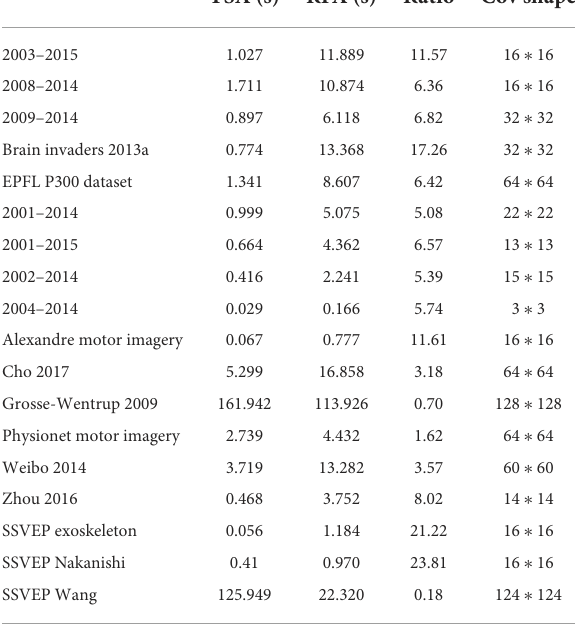
TABLE 8 Database-wise average computation time for both TSA and RPA